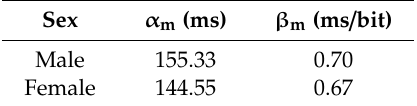
Table 5. Parameters α m and β m values for male and female individuals.